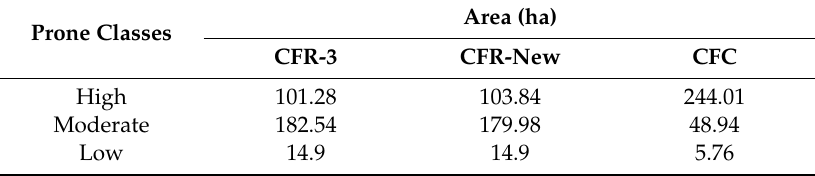
Table 8. Flood-prone area analyses from the (a) CFR-3 parameters, (b) CFR-new (c), and CFC combined